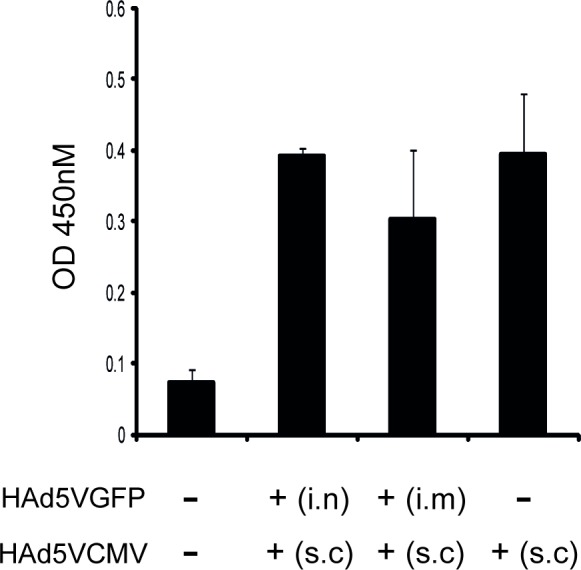
Humoral immune response to HBc protein following HAd5VCMV vaccination of HAdV pre-immunized animals or control animals.Pre-existing adenovirus-specific NAbs were induced by immunizing mice with HAd5VGFP (1x107 PFU/animal) by either i.n. or i.m. route as indicated. Four weeks later, mice were subcutaneously immunized with HAd5VCMV (3x109 PFU/animal). Control groups were injected with PBS (-) or HAd5VCMV when indicated. Serum samples were collected five days after the last immunization and analyzed by ELISA. The graph shows one of three independent experiments with at least 3 mice per group. Bars represent mean values +/- SD. (-) mice non-immunized with adenovirus; i.n.–intranasal immunization route; i.m.–intramuscular immunization route; s.c.–subcutaneous immunization route. *p = 0.0329; **p = 0.0077; ***p<0.0001.